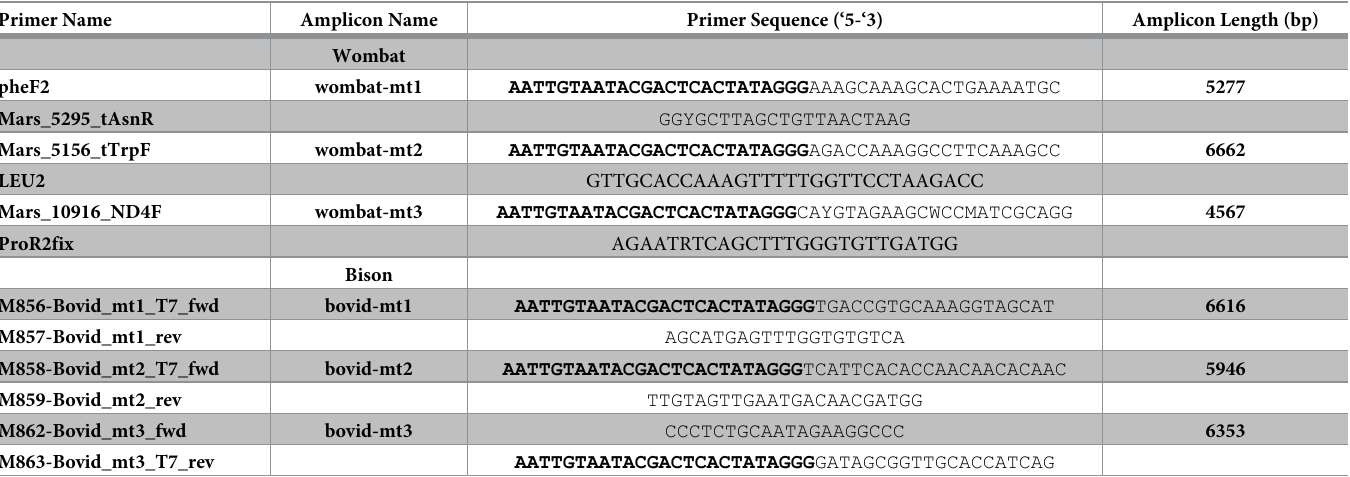
Table 1. Long-range PCR